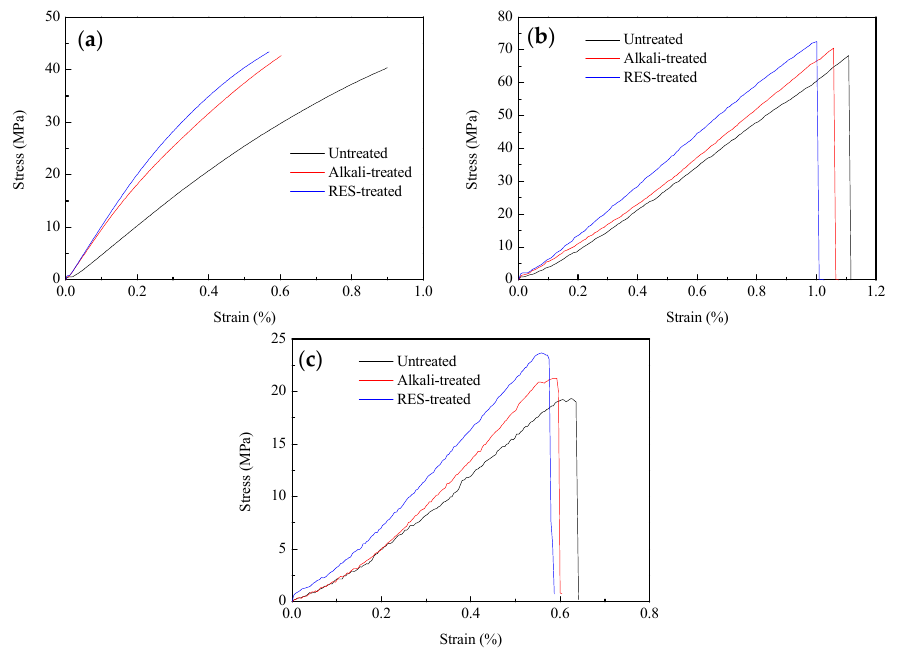
Figure 3. The stress–strain curves of composites: ( a ) Tensile test; ( b ) flexural test; ( c ) fracture toughness test. Table 4. Mechanical properties of the composites.